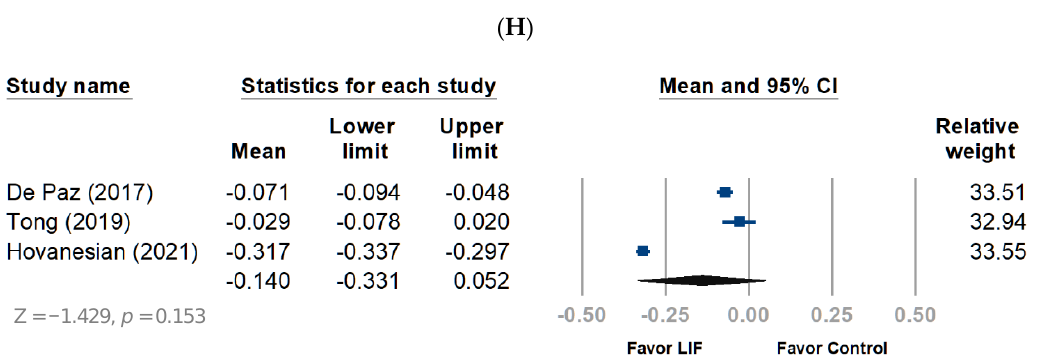
Figure 3. Forest plot of outcome measurement following treatment with lifitegrast. The mean values indicated the ratio of the mean change to each evaluating scale. LIF, lifitegrast. ( A ) Inferior corneal staining score. ( B ) Total corneal staining score. ( C ) Nasal lissamine staining score. ( D ) Tear break-up time. ( E ) Ocular discomfort score. ( F ) Eye discomfort score. ( G ) Eye dryness score. ( H ) Ocular surface disease index score.